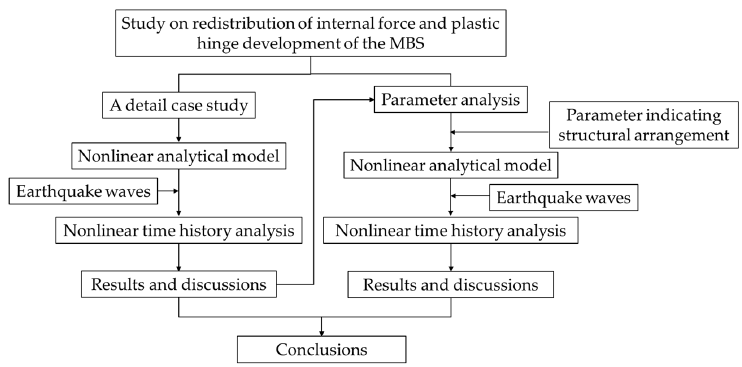
Figure 2. The flow chart of the present